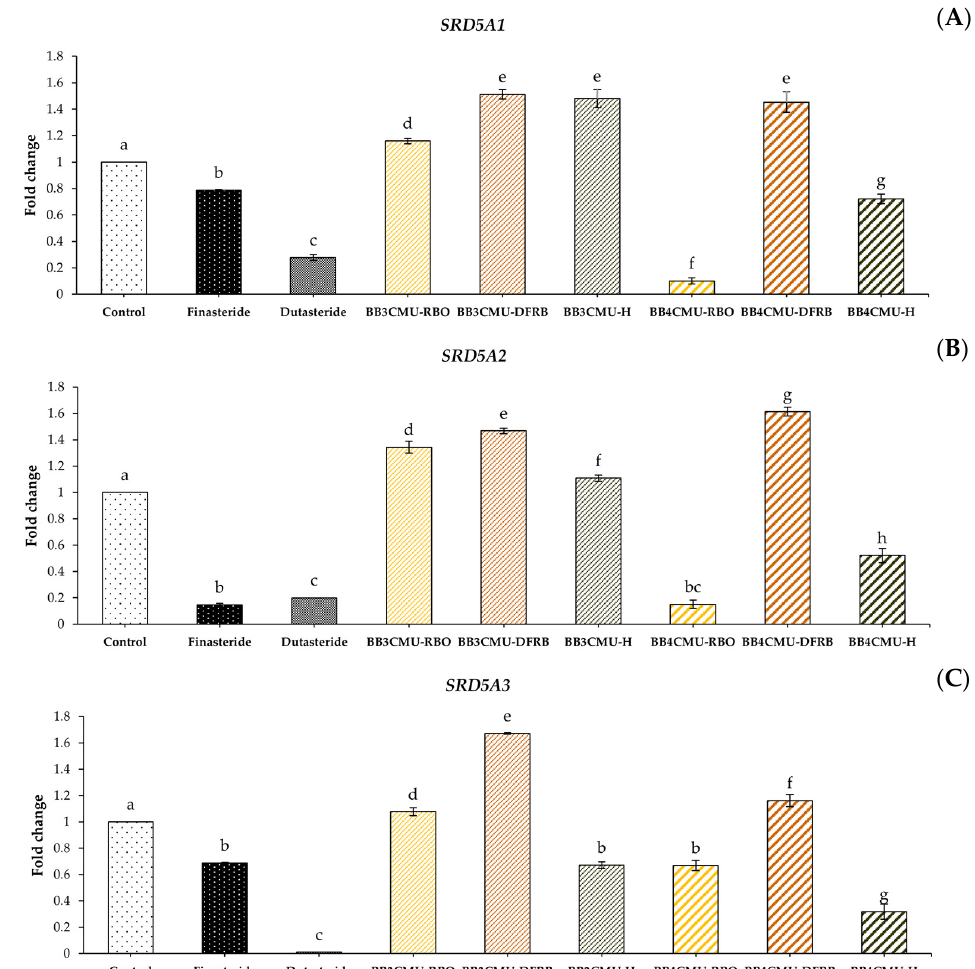
Figure 3. Effects of Oryza sativa L. cv. BB3CMU and BB4CMU extracts (RBO, 0.25 mg/mL; DFRB, 0.50 mg/mL; H, 0.10 mg/mL) on mRNA expression of ( A ) SRD5A1 ; ( B ) SRD5A2 ; ( C ) SRD5A3 in DU-145 prostate cancer cells after 24 h of treatment. Finasteride and dutasteride (0.10 mg/mL) were used as standard controls. Different letters within each treatment indicate significant differences ( p < 0.05).